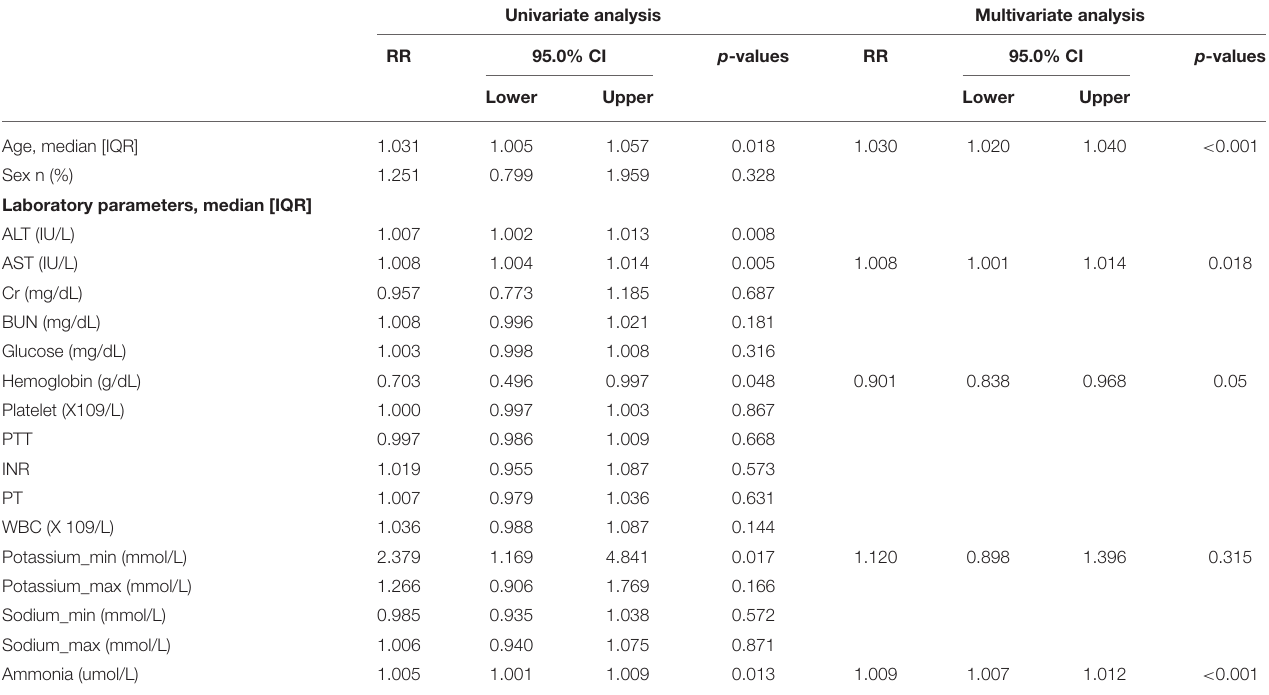
TABLE 3 | Univariate and multivariate COX analysis of risk factors to 30 day